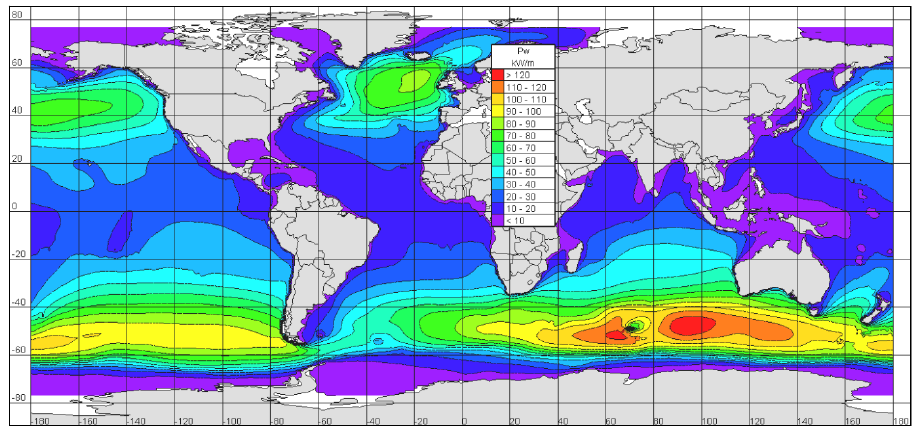
Figure 1: Global distribution of annual mean wave energy transport [6]. The colour bar indicates the total wave energy flux